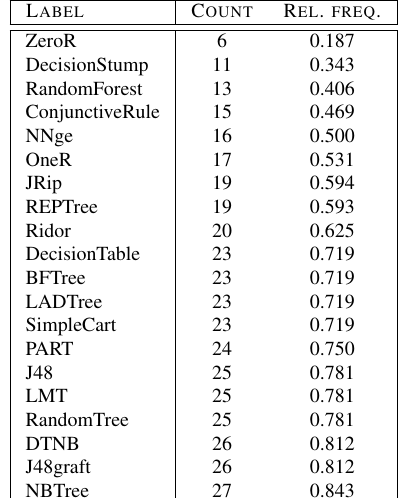
Table 6: Label frequency in the EDM multi-label data